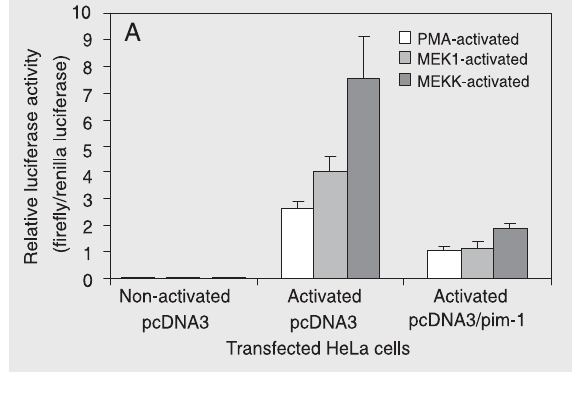
Figure 1. Pim-1 inhibits Elk-1-dependent, but not Jun-dependent transcrip- tion activity. A , Pim-1 inhibits Gal4-Elk-1 reporter expression induced by phorbol myristate acetate (PMA), constitutively active MEK1 or MEKK. HeLa cells were transfected with Gal4-Luc, Gal4-Elk-1 together with pcDNA3/pim-1 or pcDNA as control. A renilla luciferase plasmid was co- transfected as an internal control. Gal4-Elk-1 was activated either by treat- ment with PMA for 6 h or co-transfection and expression of constitutively active MEKK or MEK1. Luciferase activity was measured and normalized against the co-transfected renilla luciferase activity. B , Pim-1 inhibits Elk-1 transcription activity in a dose-dependent manner. HeLa cells were trans- fected with Gal4-Luc, Gal4-Elk-1 together with pcDNA3 or increasing amounts of pcDNA3/pim-1. The transfected cells were left untreated or treated with PMA for 6 h before measuring luciferase activity. C , Pim-1 does not inhibit Gal4-Jun activity. Cells were transfected with Gal4-Luc, Gal4-Jun and either pcDNA3, pcDNA3/pim-1 or a contitutively active mutant of MEKK as indicated in the figure. Twenty-four to 48 h after transfection, luciferase activity was determined as